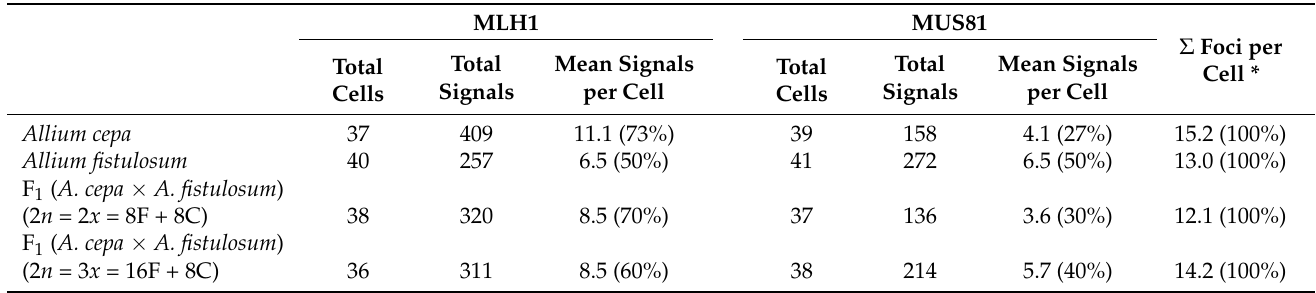
Table 3. The frequency of MLH1 and MUS81 signals separating on ZYP1 tracks at the pachytene of A. cepa , A. fistulosum , and the F 1 diploid and triploid hybrids ( A. cepa × A. fistulosum ).